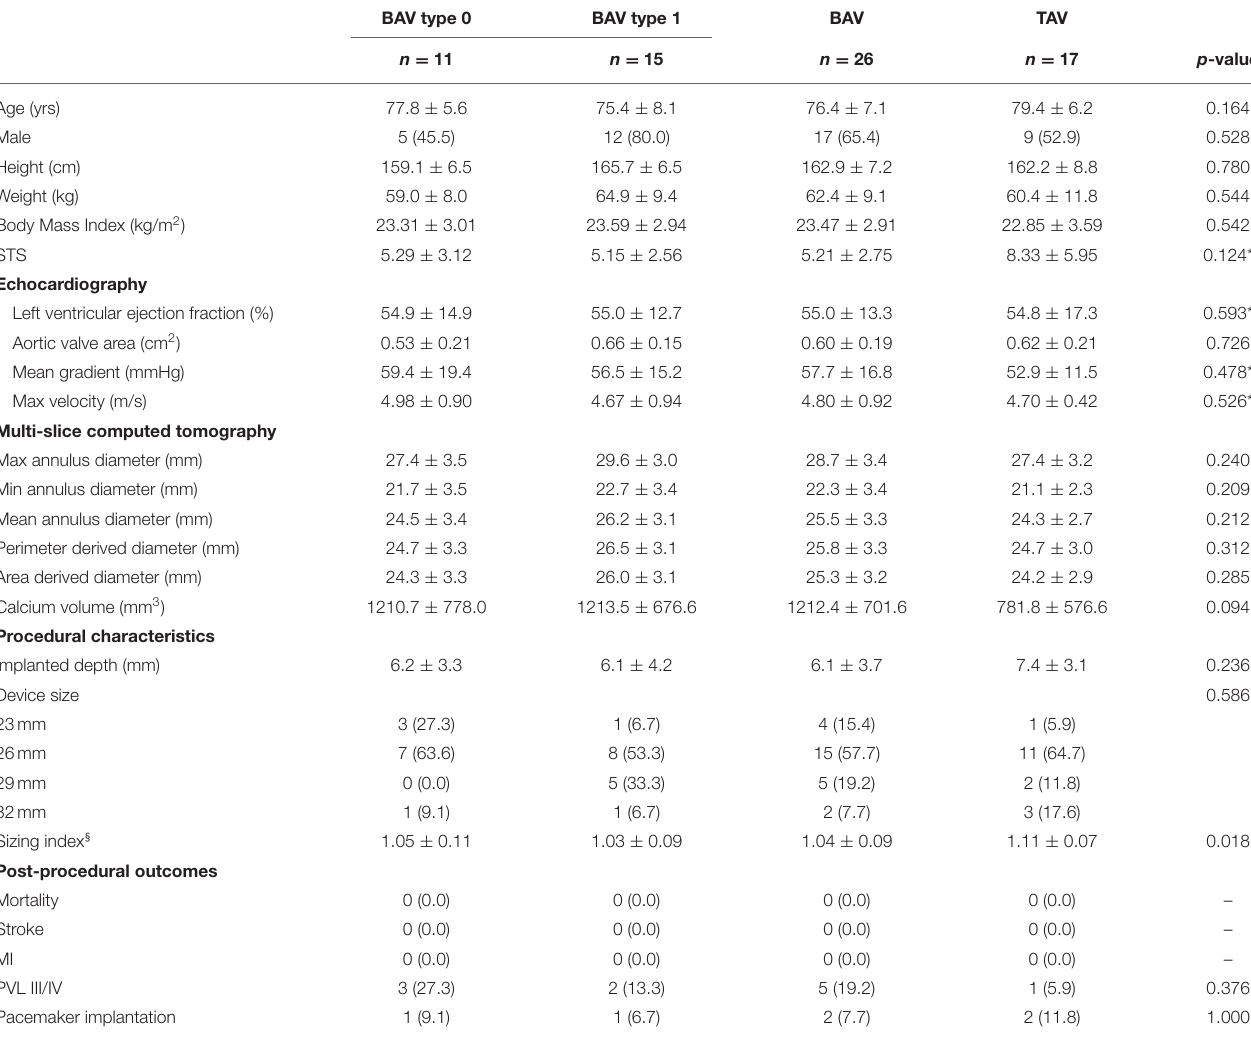
TABLE 1 | Patient characteristics.